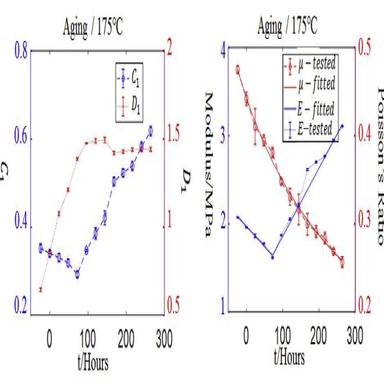
Changes of parameters during accelerated aging.